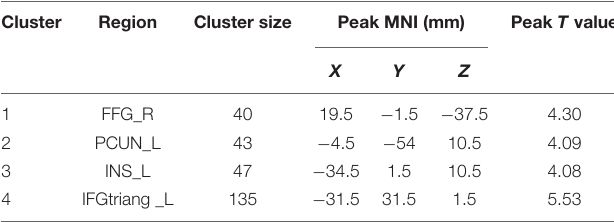
TABLE 2 | Brain regions in which GMV was significantly correlated to total